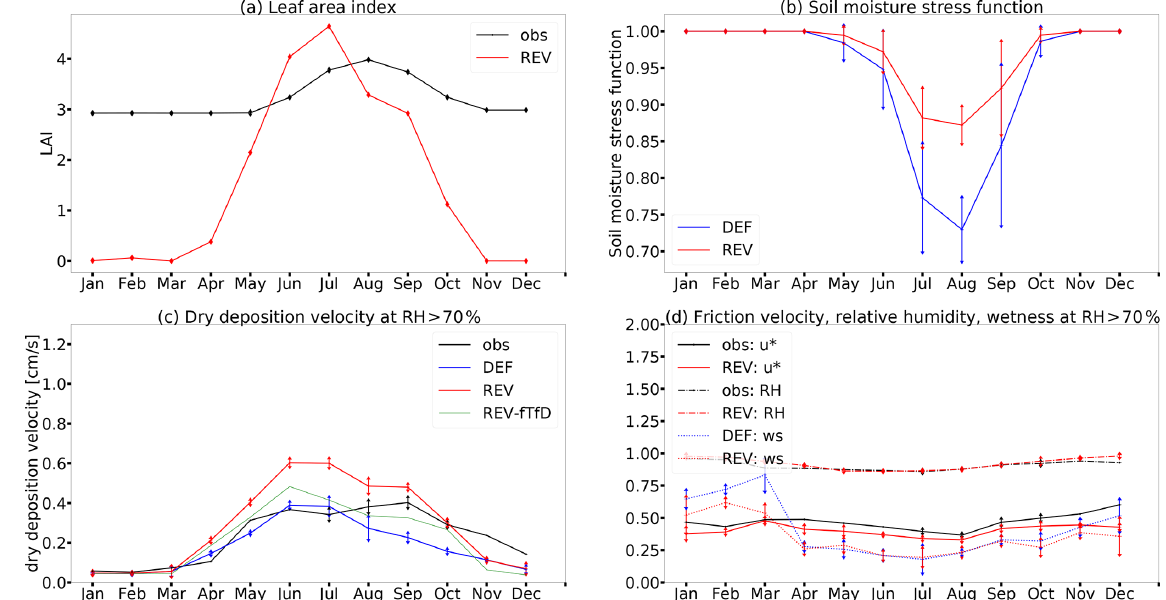
Figure B2. Measured (obs) and modelled (DEF, REV) multiyear (2010–2012) and REV-fTfD (2010) annual cycles at Hyytiälä.